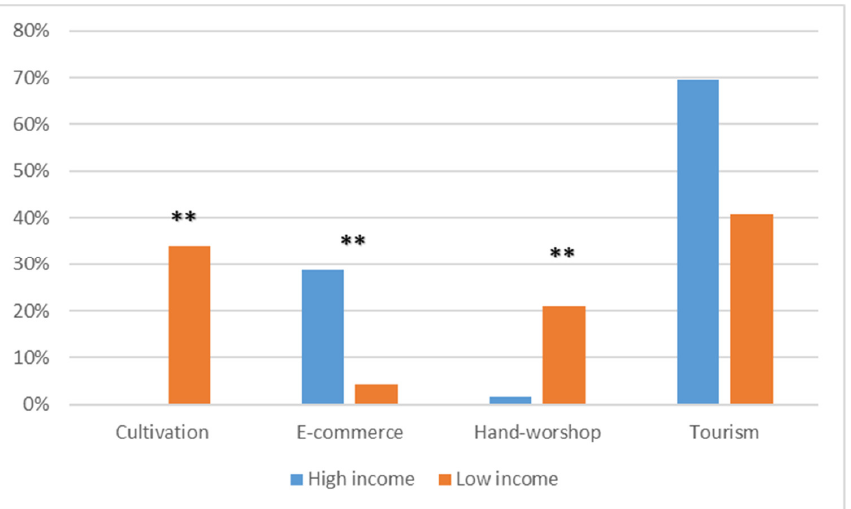
Figure 10. Variations in future industry, as perceived and preferred by respondents from high- and low-income groups. Asterisks indicate significance level: ** means p ≤ 0.01.